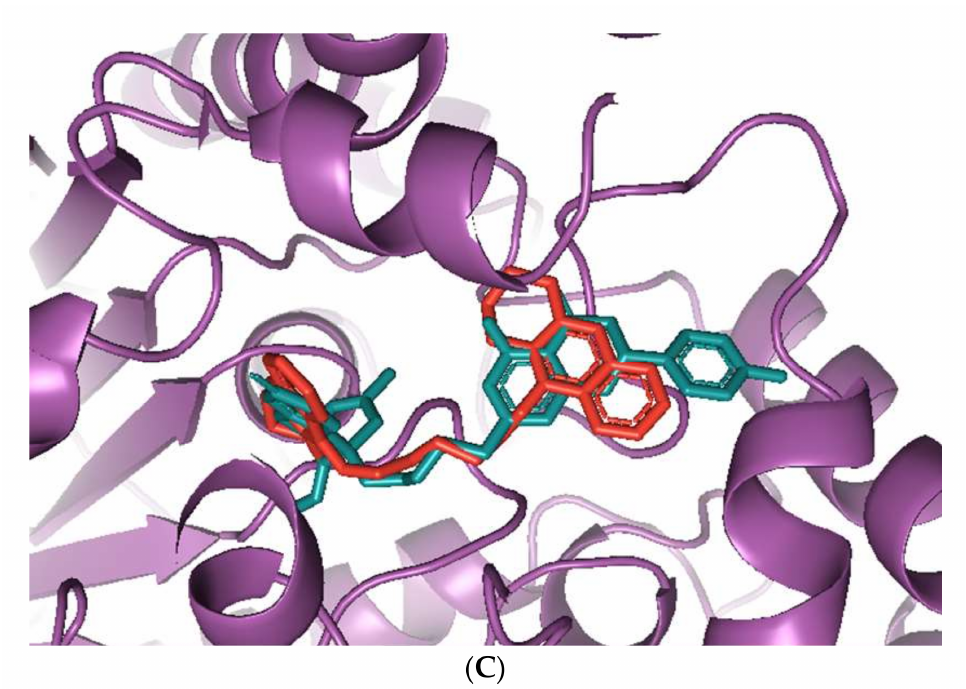
Figure 2. Docking models of huperzine-4C-naringenin (colored cyan) binding to the active site of AChE enzyme (colored purple). ( A ) Binding pose of huperzine-4C-naringenin looking down the catalytic gorge of AChE. ( B ) Ligand huperzine-4C-naringenin docked with the binding site residues of AChE. Hydrogen bonding is represented by red lines and the distance measured in Å. ( C ) Huperzine-4C-naringenin superimposed with a bis-tacrine dimer (colored red) pre-bound into the crystal structure of the AChE enzyme target (PDB ID: